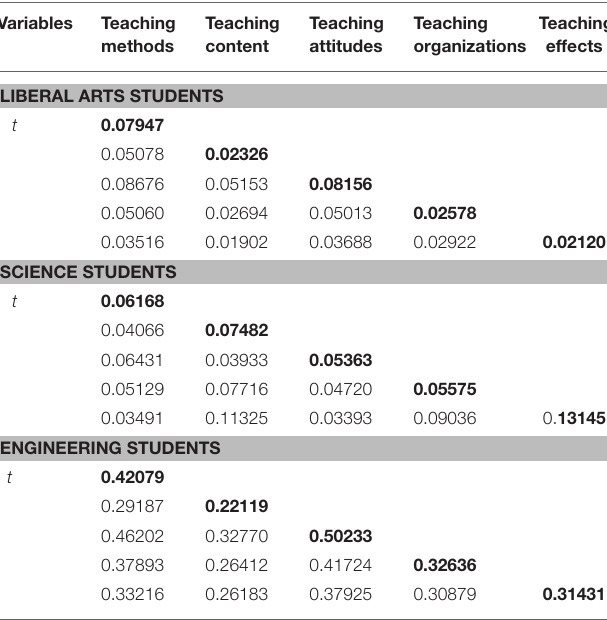
TABLE 7 | Variance components and covariance components from G study, effect of major